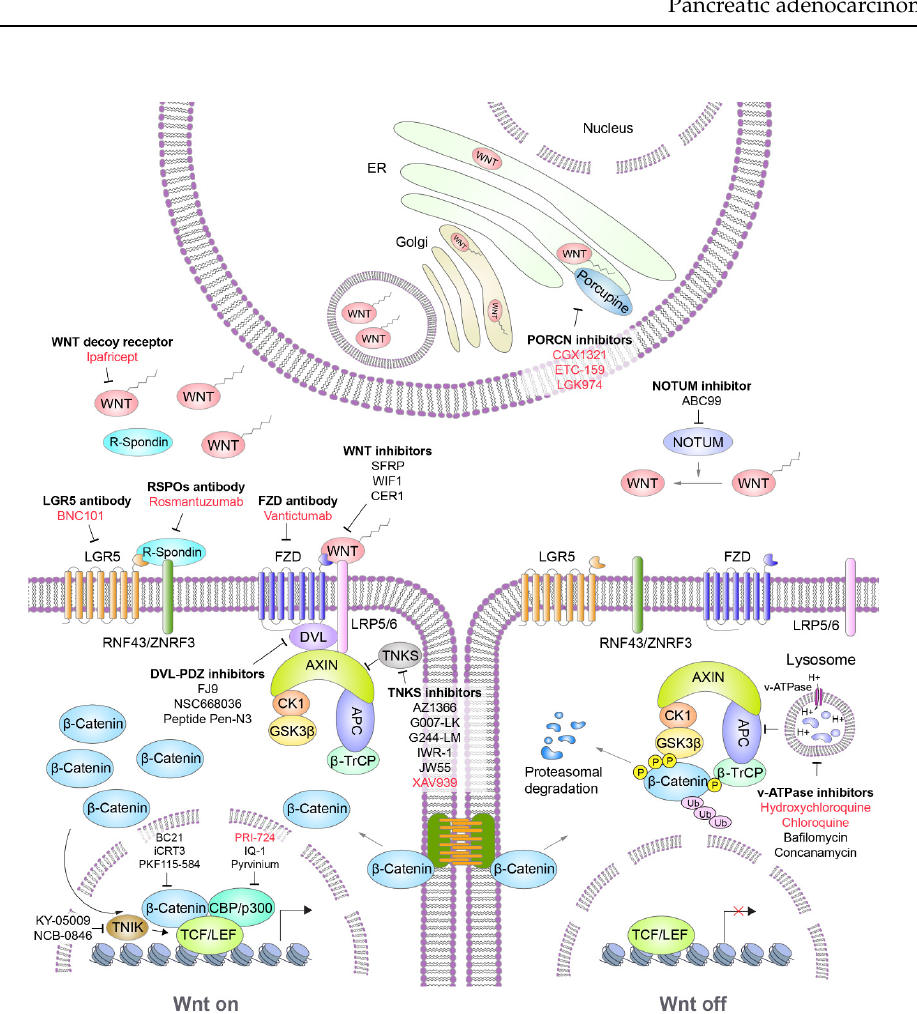
Figure 2. Wnt targeting agents for the Wnt/ β -catenin signaling pathway. Wnt targeting agents for GI cancers mainly focus on the inhibition of the key molecules in Wnt/ β -catenin signaling, such as inhibiting WNT ligands (ipafricept, LGK794), inhibiting Wnt receptors/coreceptors (vantictumab, rosmantuzumab), stabilizing the destruction complex (AZ1366, hydroxychloroquine), and inhibiting β -catenin-dependent transcriptional machinery (MSAB, PRI-724).